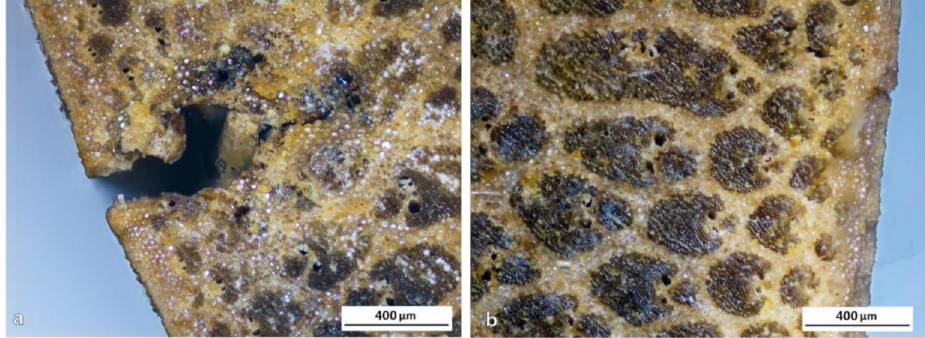
Figure 12. OM images showing defects in DS bamboo: ( a ) skin imperfections and ( b ) morphologi- cal irregularity.